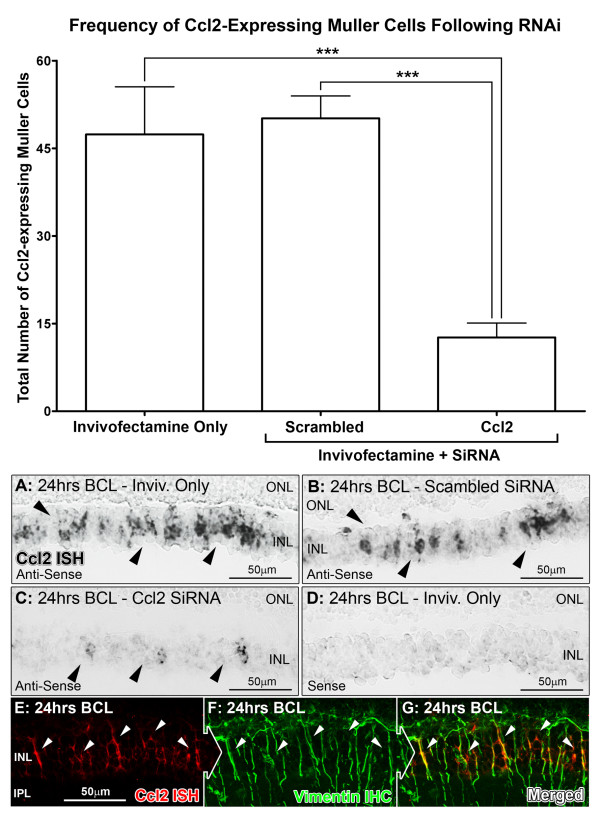
Chemokine (C-C motif) ligand (Ccl)2 expression in Müller cells following Ccl2 small interfering (si)RNA treatment and light damage. (A–C) Representative images taken from the superior mid-periphery showing in situ hybridization results for Ccl2 mRNA within processes situated in the inner nuclear layer (INL) following exposure to bright continuous light (BCL; black arrows). (D) Sense controls showed no specific staining. (E–G) Co-labelling for Ccl2 mRNA with a fluorescent stain (red) showed colocalization for vimentin-immunoreactive (green) Müller cell processes (white arrows). The histogram shows that the number of Ccl2-expressing Müller cells per retina decreased significantly in the Ccl2 siRNA-treated group (12.6 cells) compared with the Invivofectamine-only (47.4 cells; P < 0.05) and the scrambled siRNA (50.1 cells; P < 0.05) groups. Inivofectamine-only (n = 4), scrambled siRNA (n = 4), Ccl2 siRNA (n = 4). Error bars represent SEM. *Significant change at P <0.05 using ANOVA with Tukey’s post hoc test. ONL, outer nuclear layer.